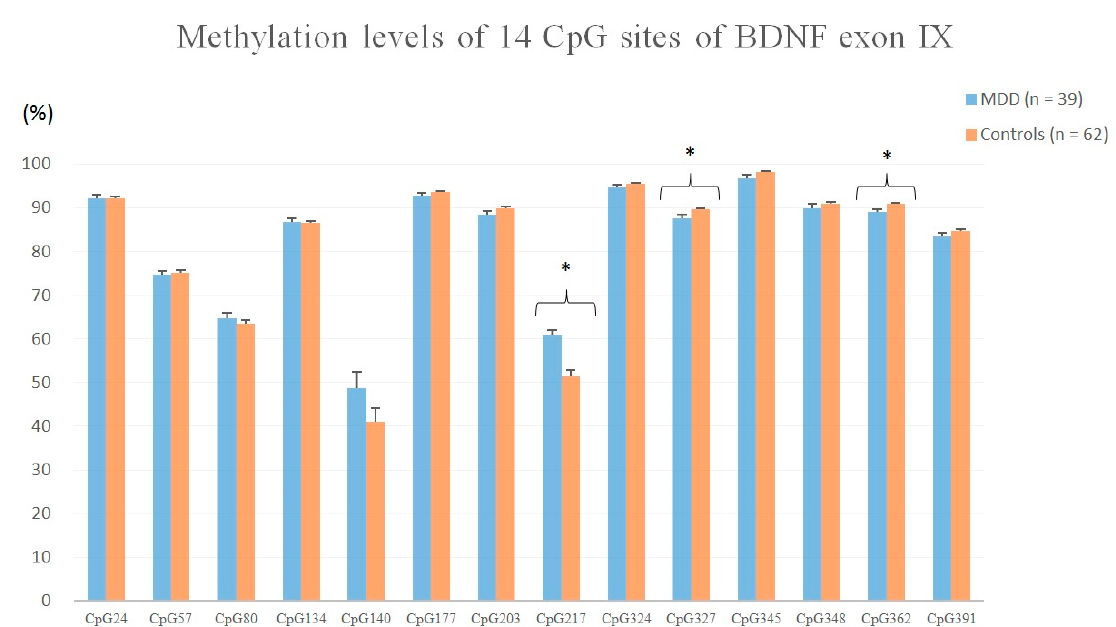
Figure 1. Methylation levels of 14 CpG sites of BDNF exon IX in patients with MDD and the healthy controls. (* p < 0.05)